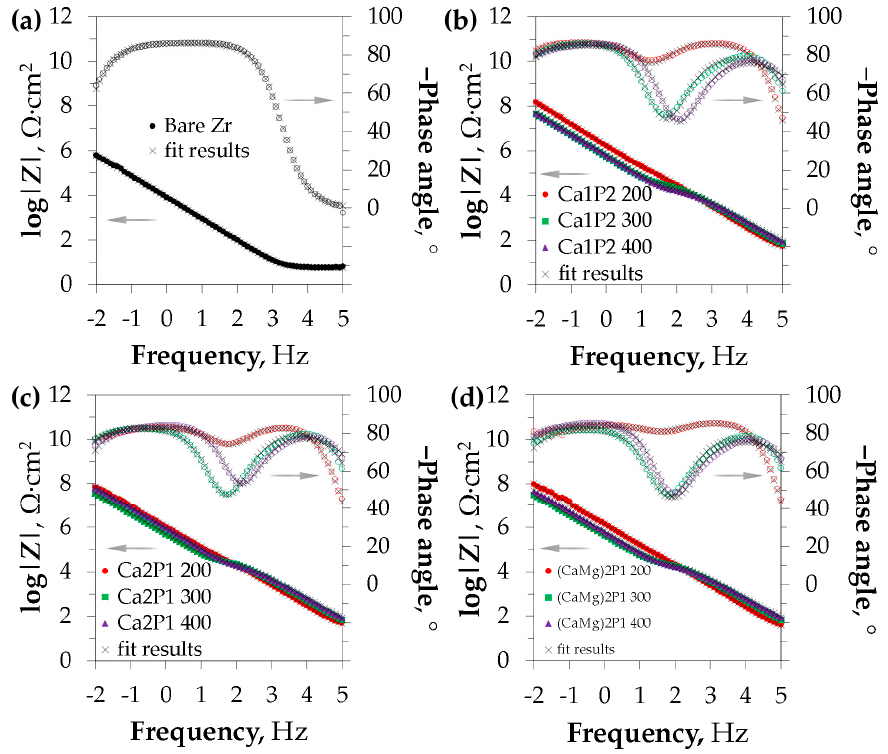
Figure 8. Bode modulus ( | Z | ) and phase angle plots belonging to the bare zirconium surface ( a ) and the PEO coatings formed in the Ca1P2 ( b ), Ca2P1 ( c ), as well as (CaMg)2P1 ( d ) solutions. Arrows indicate the data sets that correspond to the specific axes.